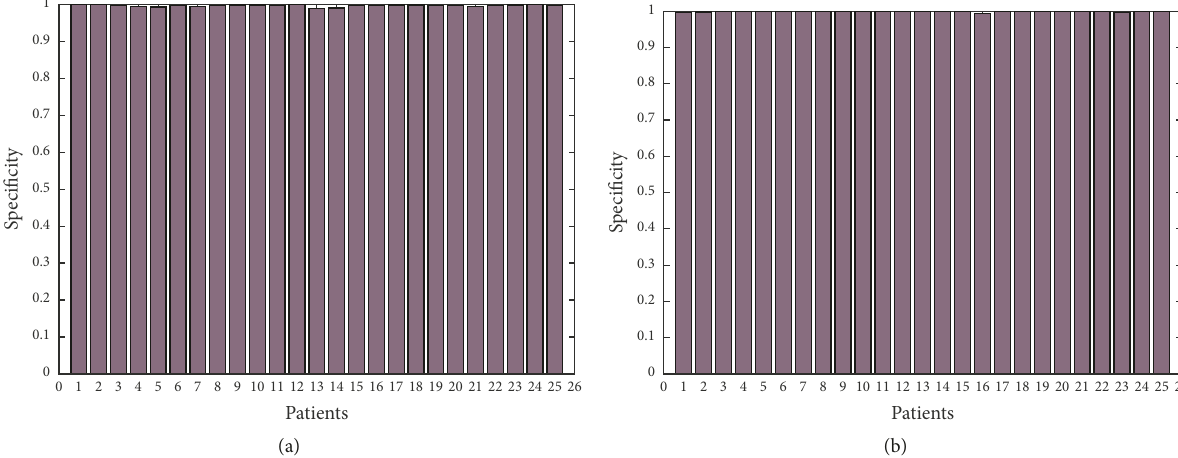
Figure 12: Specificity in thermal images for 50 patients; (a) 25 with high-grade taken from BRATS 2012; (b) 25 with low-grade taken from BRATS 2013.